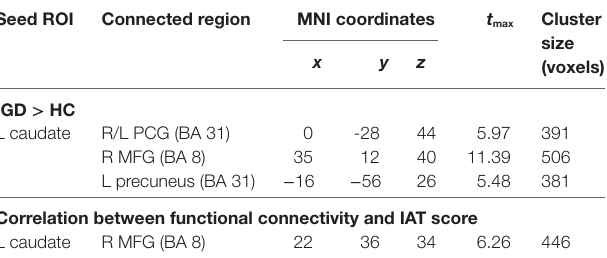
TaBle 3 | Differences in functional connectivity a between the IGD group and HC reveal a positive correlation with IGD severity.